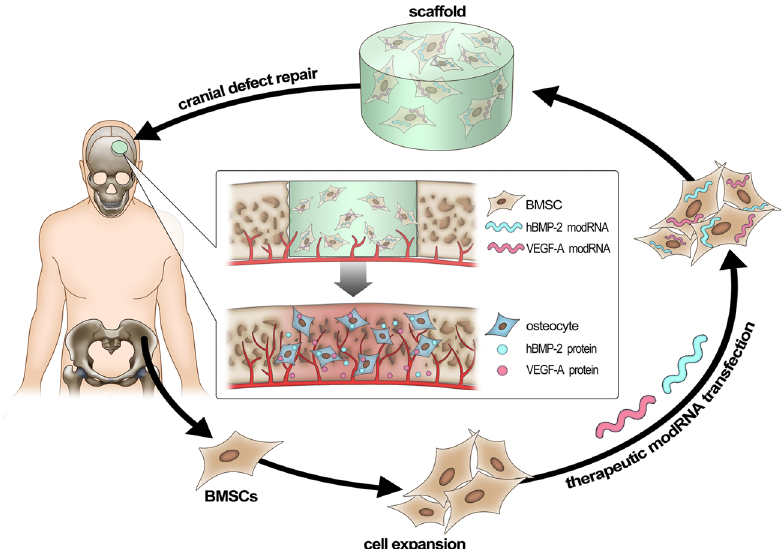
Fig. 7 Schematic diagram illustrates the clinical feasibility of combining biomaterials with modRNA-treated BMSCs for bone repair. Our platform favors an autologous cell therapy approach where human BMSCs are isolated from bone marrow of ilium and expanded in vitro. BMSCs are then engineered with modi fi ed mRNAs and are inoculated into scaffolds, which are implanted into human bone (cranial) defect